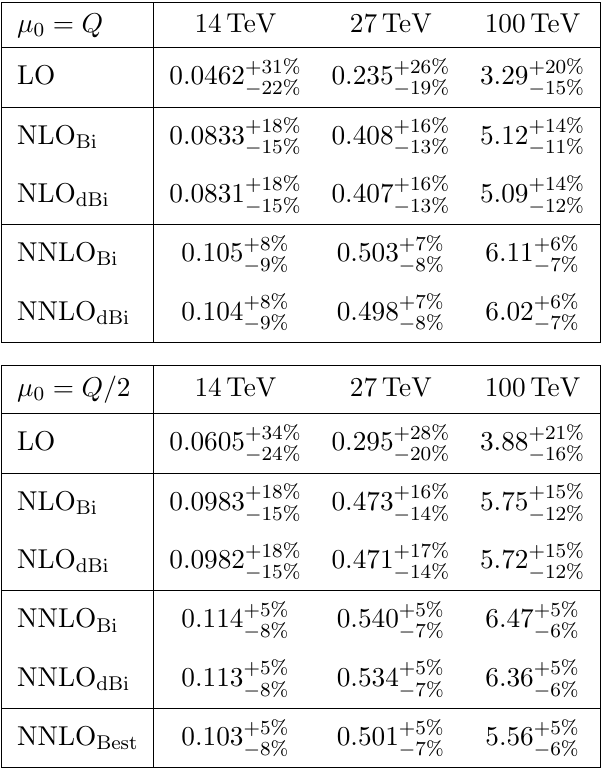
Table 1 . Results for the inclusive cross-section (in fb) of triple Higgs boson production for di(cid:11)erent collider energies, calculated at di(cid:11)erent orders and with the di(cid:11)erent reweighting procedures. The results are shown for central scale values of Q (top) and Q= 2 (bottom). The dependence on (cid:24) in the dBi (cid:24) reweight procedure is below the per-mill level and therefore omitted. The last row shows our best available prediction for the di(cid:11)erent collider energies. The uncertainties correspond to the scale